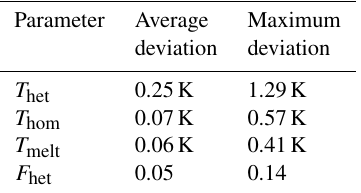
Figure 2. A typical DSC thermogram, showing freezing onset tem- peratures T hom and T het constructed with the asymptotes of the ho- mogeneous and heterogeneous freezing peaks, respectively, as well as the frozen fractions F hom and F het resulting from the integral between the DSC curve and the blue horizontal line as the base- line. The area underneath the curve corresponds to the frozen water volume (if the temperature dependence of the enthalpy of freezing is neglected; Speedy, 1987; Johari et al., 1994). All depicted DSC thermograms in this study are normalized with respect to their total integral, i.e., F het + F hom = 1. The homogeneous onset temperature is taken as the separator between the two peak areas. Note that in- tegrals are determined in the time domain (heat flow vs. time) and not in the temperature domain, which is shown here. Table 2. Summary of statistical uncertainties of measurement pa- rameters. Stated are the average standard deviation of T het , T hom , T melt , and F het determined as the average of the standard deviations from all measurement points shown in Figs. 3, 4, 7, and 8, as well as the maximum standard deviation observed for each measurement